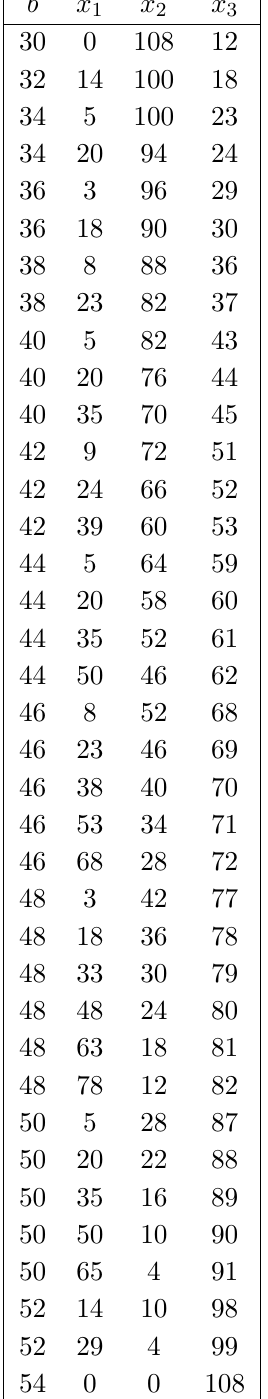
Table 3 . Anomaly-free T = 0 U(1) models with maximum charge q = (cid:6) 3 that cannot be unHiggsed to an anomaly-free SU(2) model because of the NGIN